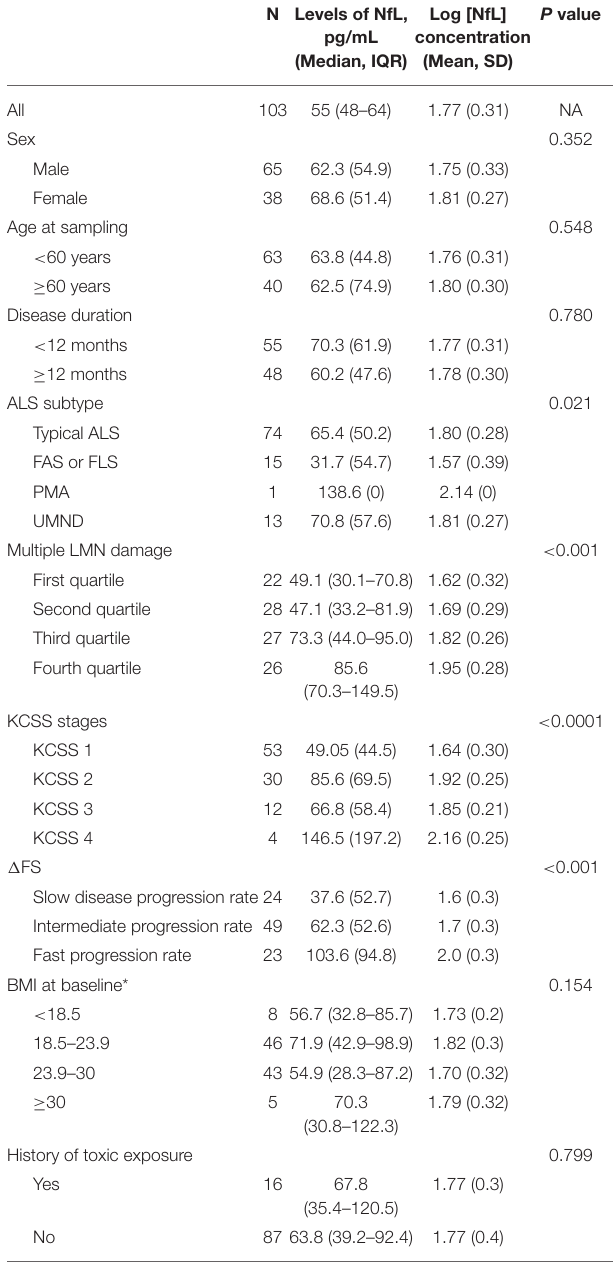
TABLE 1 | Study participant characteristics: all participants.